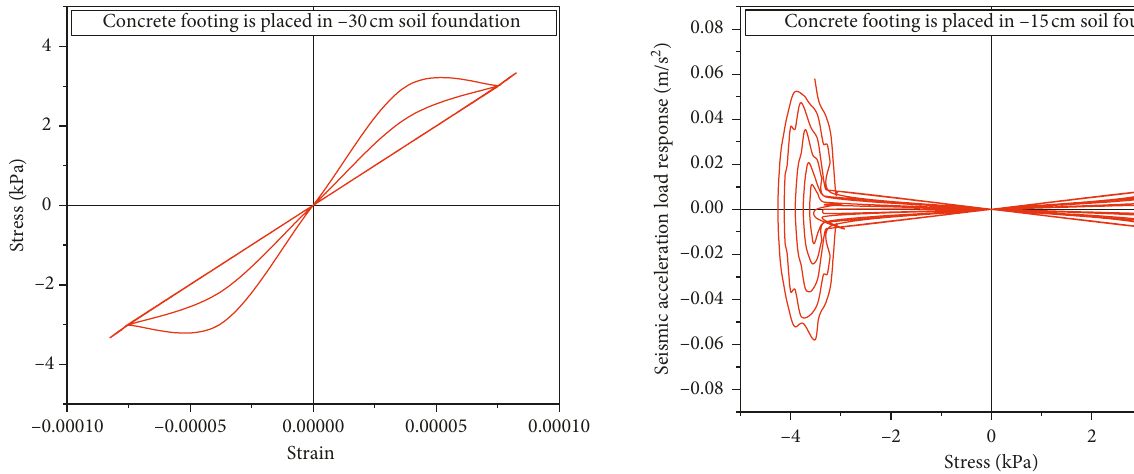
Figure 13: Shear stress vs shear strain at the base of a concrete footing, during concrete footing-soil foundation interaction.